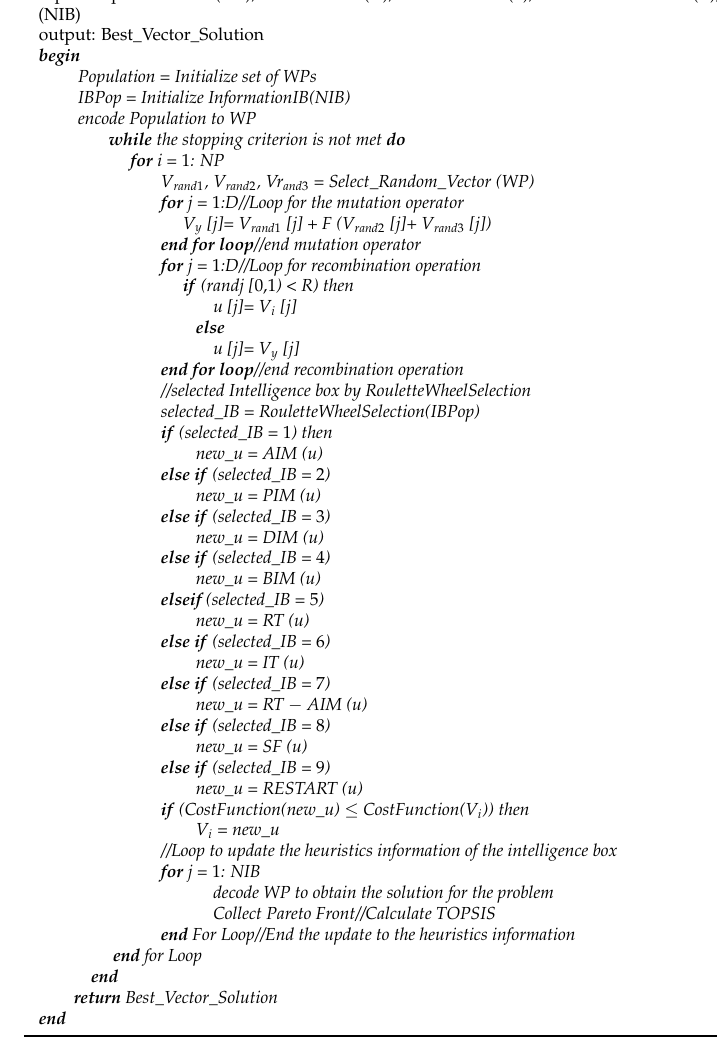
Algorithm 1. Artificial multiple intelligence system